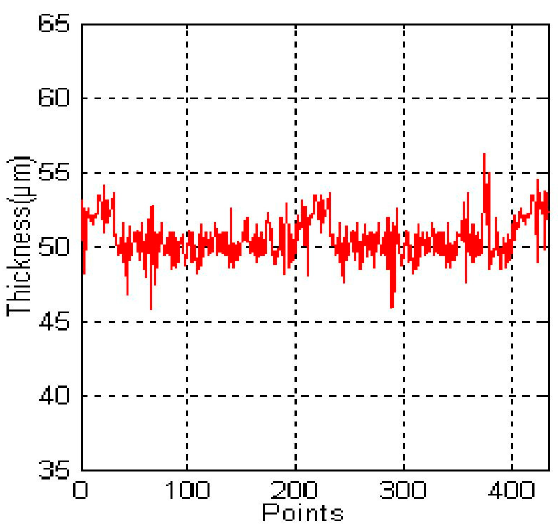
Figure 17. Oil film thickness data curve.